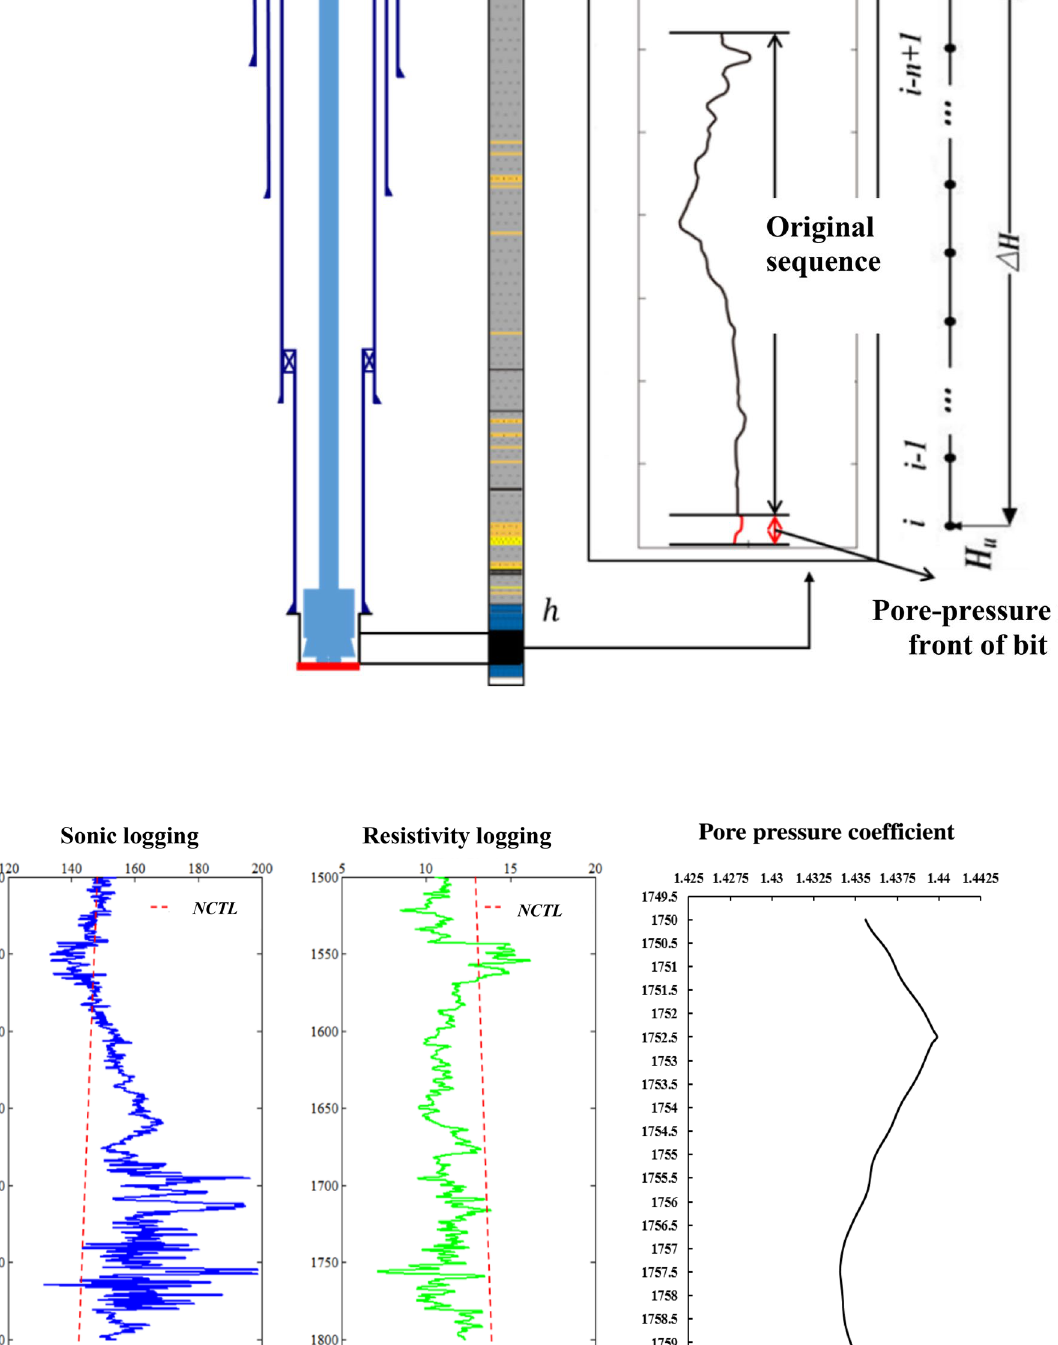
Fig. 1 Sketch map of formation pressure prediction in front of bit based on grey theory